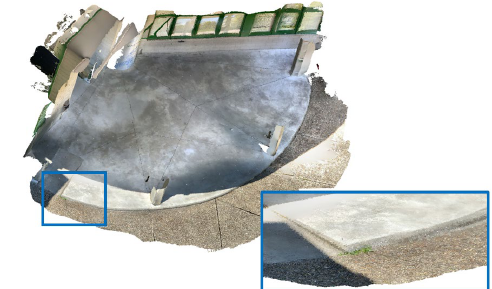
Figure 3: An outdoor scene corresponding to a building entrance, including a zoom in to a ramp.